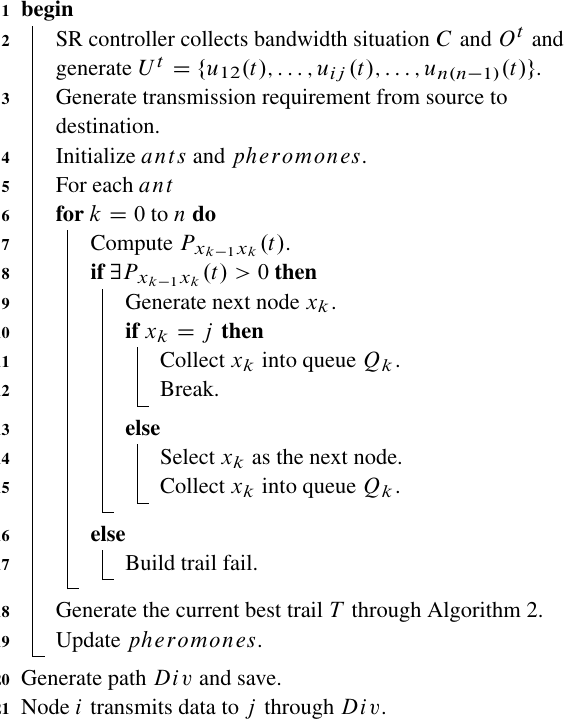
Algorithm 3: (cid:4) Bandwidth load